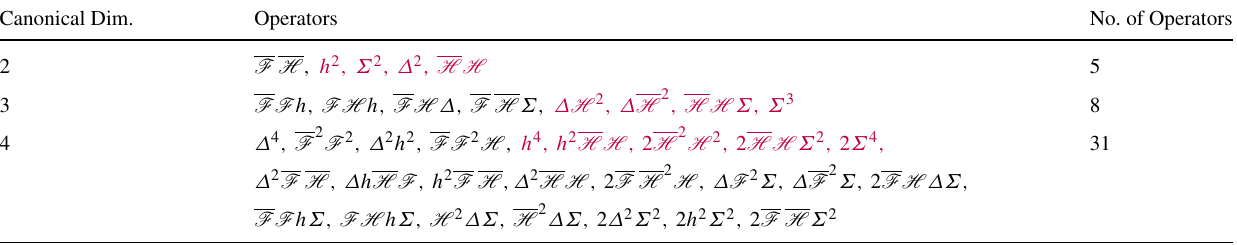
Table 54 Supersymmetric Pati-Salam Model: Operators constituted only of chiral superfields. Terms in red correspond to the operators given in [194] Canonical Dim.